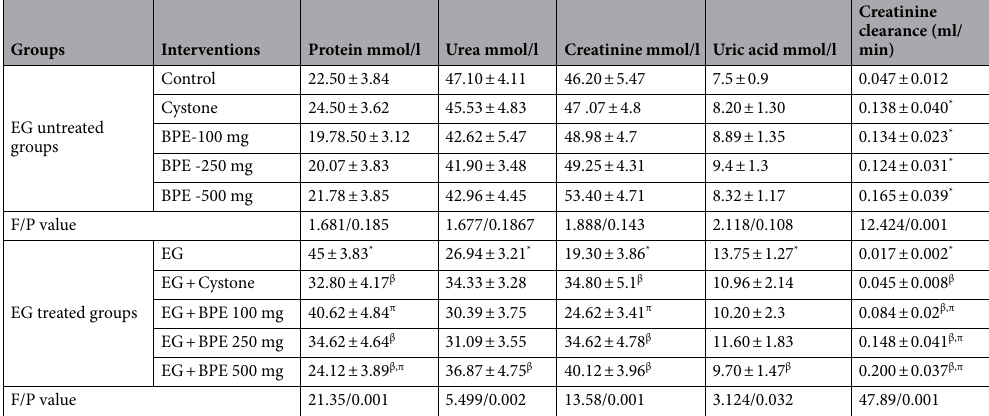
Table 6. Effect of the interventions on urine proteins, urea, creatinine, and uric acid and on creatinine clearance on day 30. * P < 0.05 as compared to EG untreated-control group. # P < 0.05 as compared to EG untreated-cystone group. β P < 0.05 as compared to EG treated group. π P < 0.05 as compared to EG treated-EG + cystone group.